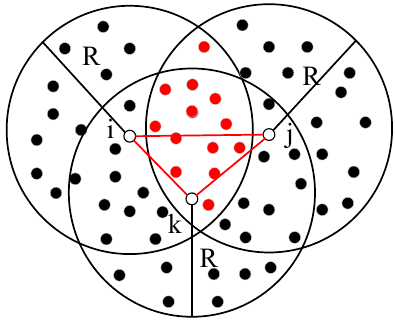
Figure 4. Communication between two nodes with two hops.